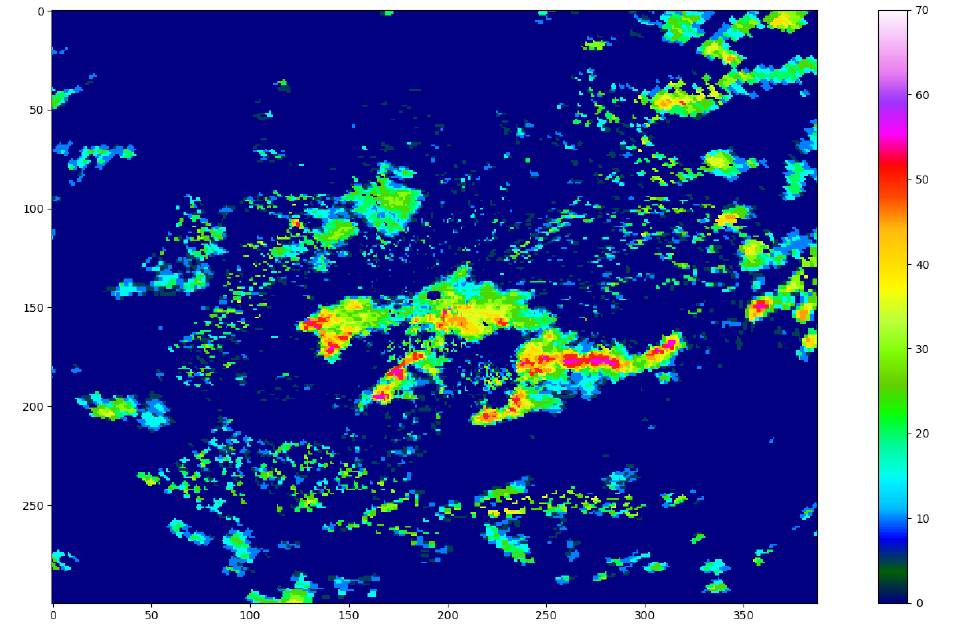
Figure 9. Real data for product R 01 (reflectivity at the lowest elevation angle, measured in dBZ with values ranging form 0 to 70) at 14:37:22 UTC.